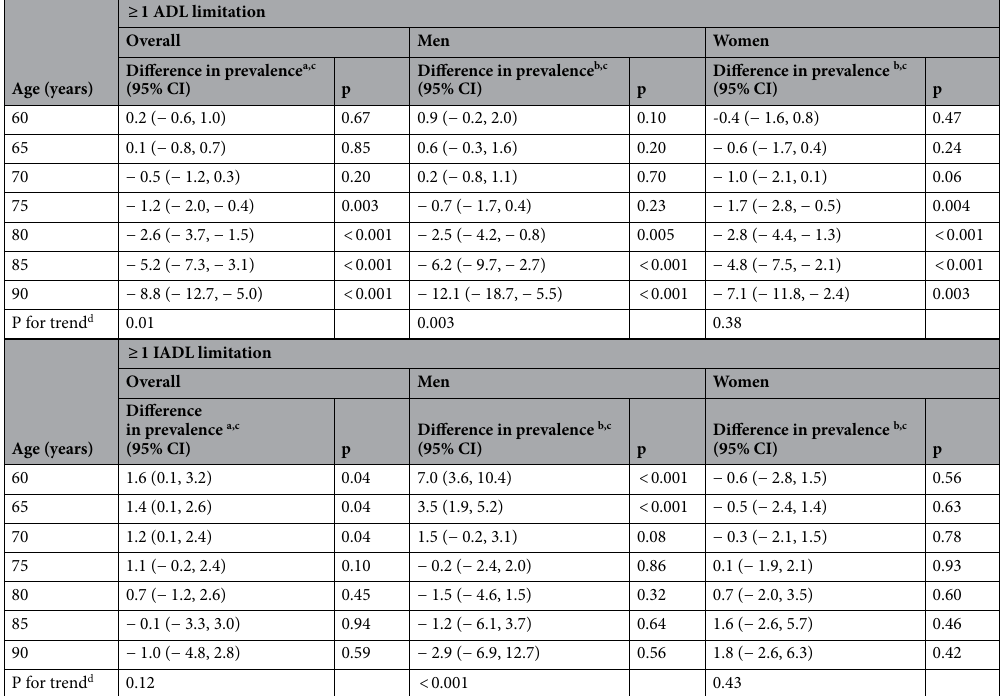
Table 2. Difference between HS-2008 and CARE-2015 in ADL and IADL limitations as a function of age and by sex. HS, Handicap Santé; CARE, Capacities, Aids and REssources; ADL, Activities of Daily Living; IADL, Instrumental Activities of Daily Living. a Estimated using weighted logistic models adjusted for survey (HS-2008, CARE-2015), age, age 2 , survey × age, sex, multimorbidity, education, and for significant interactions between covariates and age terms. b Estimated using weighted logistic models stratified on sex and adjusted for survey (HS-2008, CARE-2015), age, age 2 , survey × age, multimorbidity, education and for significant interactions between covariates and age terms. c Negative values indicate higher prevalence in HS-2008 compared to CARE-2015. d p value for survey by age interaction (Wald test) to test whether differences by surveys vary by